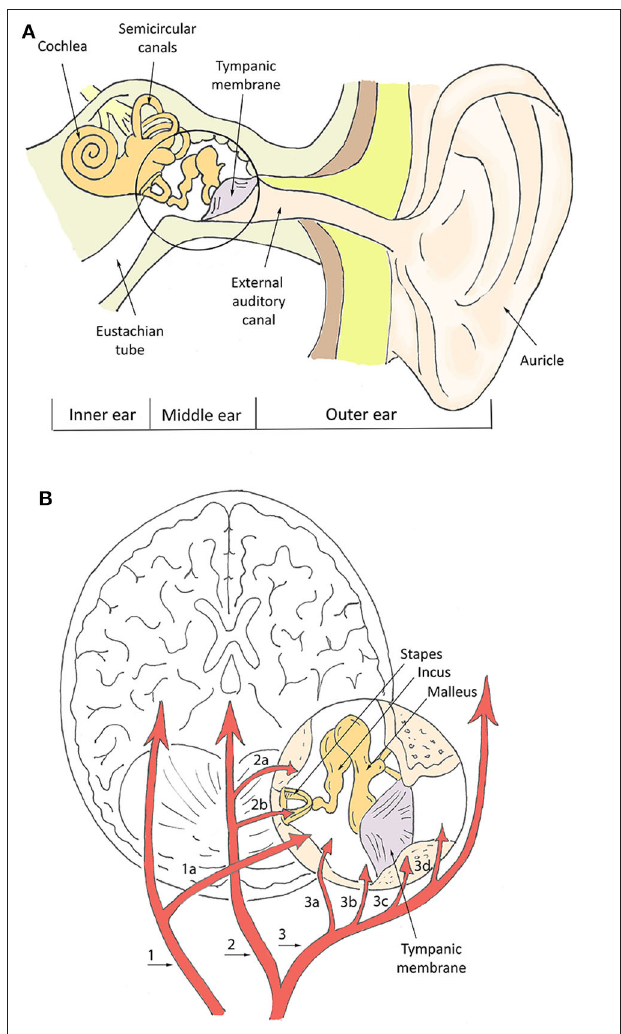
FIGURE 1 | Schematization of ear canal anatomy (A) and vasculature (B) . In (B) , numbers indicate the main vessels and specifically: the basilar artery (1), internal auditory artery (1a), internal carotid artery (2), artery of pterygoid canal (2a), carotico-tympanic artery (2b), external carotid artery (3), maxillary artery (3a), stylomastoid artery (3b), posterior auricular artery (3c), anterior tympanic artery (3d).